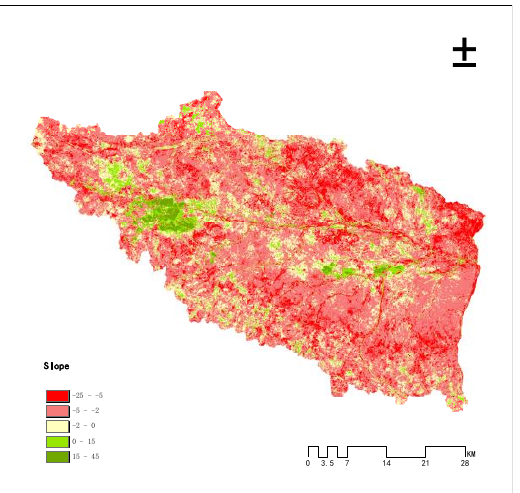
Figure 6. Average value of AGB in grassland in the Muli region from 2000 to 2021.